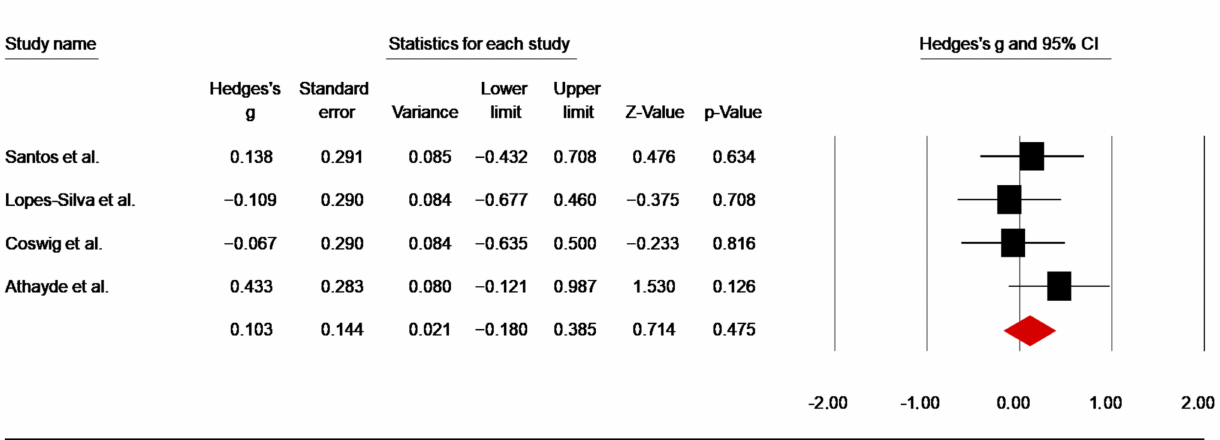
Figure 13. Forest plot of the effect of caffeine on RPE post-combat